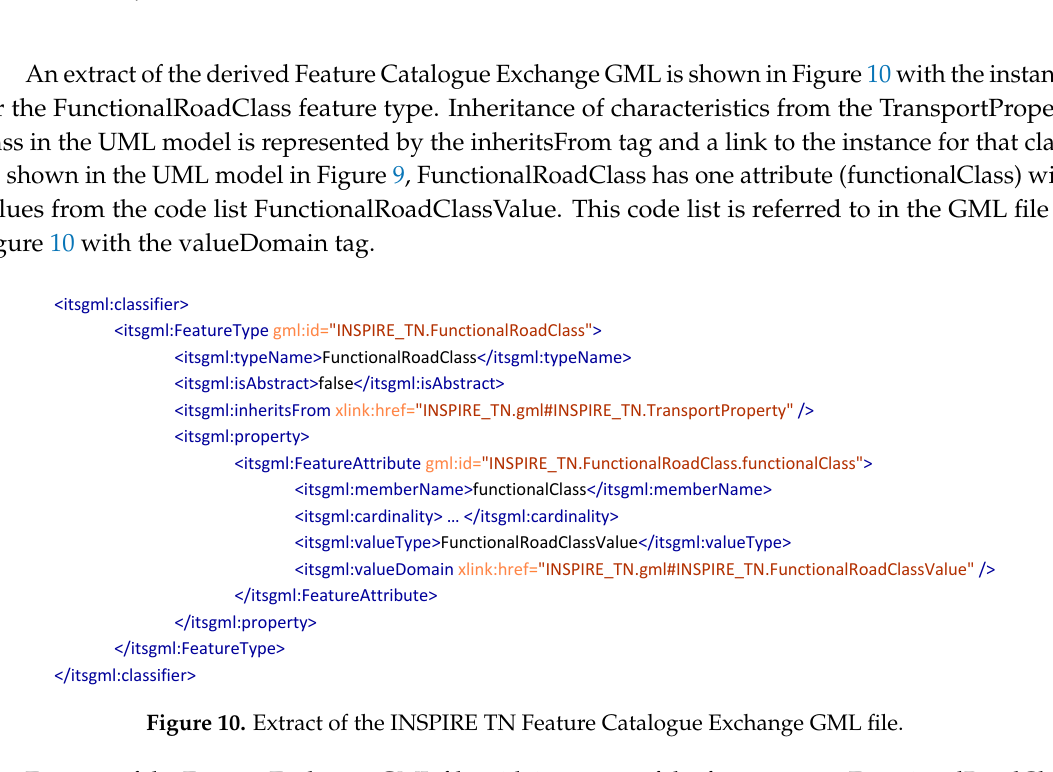
Figure 10. Extract of the INSPIRE TN Feature Catalogue Exchange GML file.